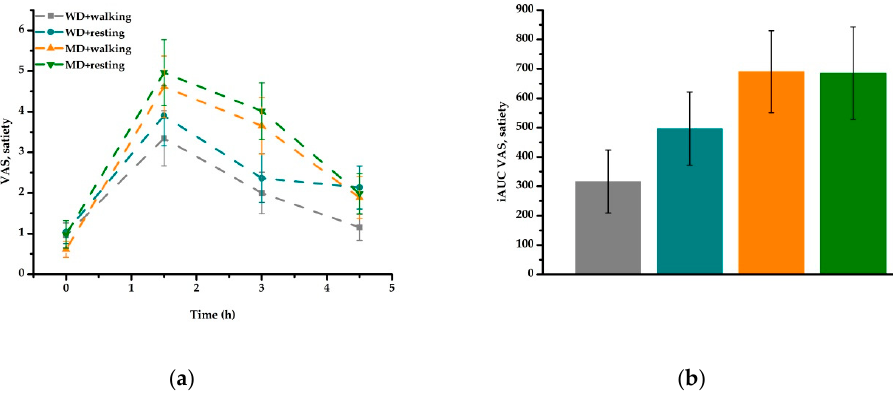
Figure 3. Fasting and postprandial satiety according to treatment condition: ( a ) satiety increased over time ( P < 0.001) with higher values for MD compared to WD ( P < 0.001). ( b ) iAUC data confirmed the observed meal e ff ect ( P = 0.004). iAUC, incremental area under the curve; MD, Mediterranean-type diet meal; VAS, visual analogue scale; WD, Western diet high-fat